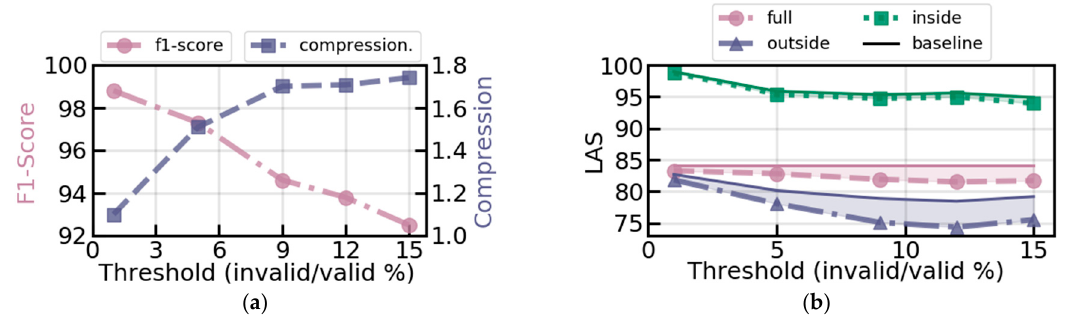
Figure 2. ( a ) NCRF++ performance and the corresponding compression rate for different rule sets. ( b ) Inside (green, square), outside (blue, triangle), and full-system (magenta, circle) scores using NCRF++ chunker for different rule sets. Baseline refers to the performances of the baseline model for the corresponding sections that were sent to each sub-parser and are displayed as continuous